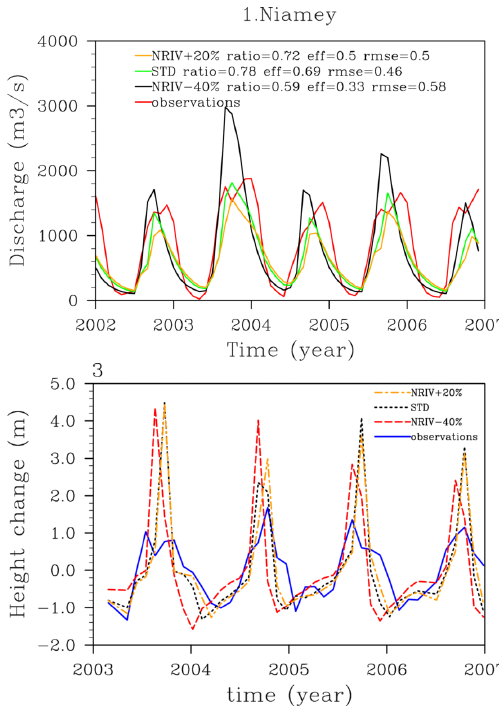
Fig. 16. Impact of the Manning coefficient on the river discharges and on the river height changes (RFEH is used as forcing). The stan- dard run stands for the simulation AQ-F with standard parameters (used for the simulations in previous